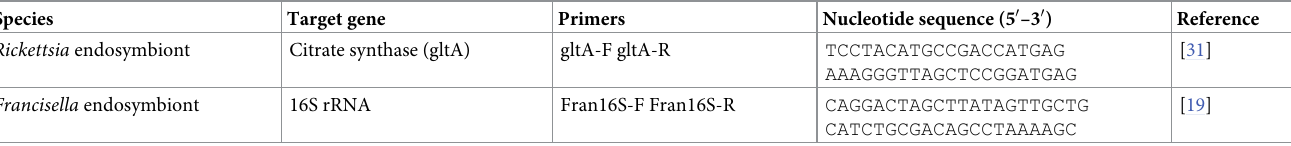
Table 2. Targeted genes, primers, and nucleotide sequences per tick